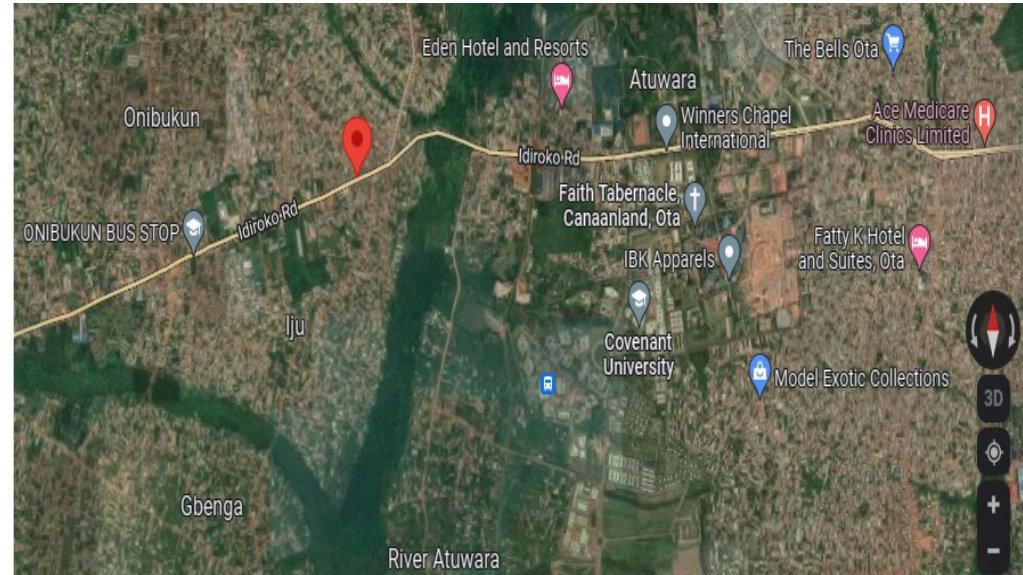
Figure 2. A map showing the location where the soil was obtained [112].